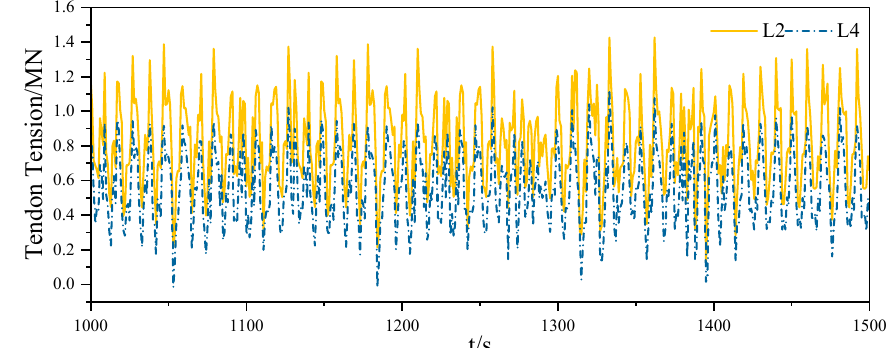
Figure 27. Tendon tension of L2 and L4 when the inclined angle is 30°.